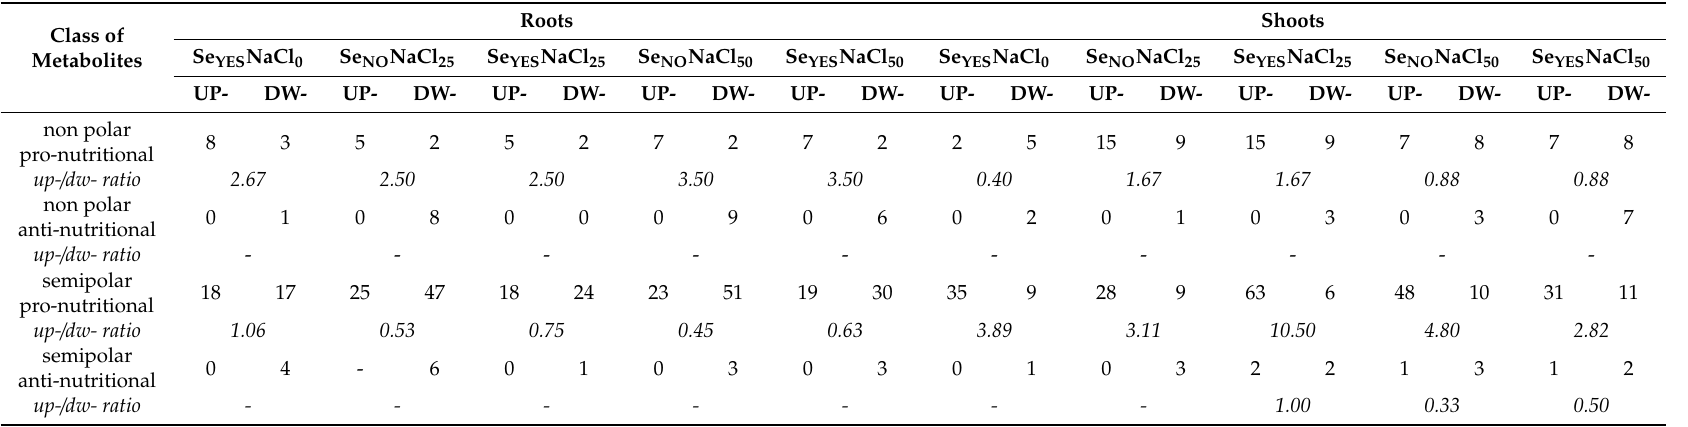
Table 5. The total number of di ff erentially accumulated non-polar and semipolar metabolites with pro-nutritional and anti-nutritional properties in maize sprouts obtained at 0, 25, or 50 mM NaCl (i.e., NaCl 0 , NaCl 25 , and NaCl 50 , respectively) from grains produced without or with Se fertilization (i.e., Se NO and Se YES , respectively) in comparison to the control Se NO NaCl0. For each group and tissue / treatment, the ratio between up- and dw-accumulated compounds is